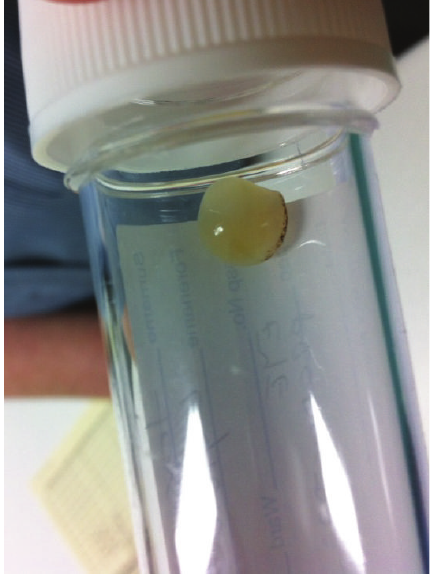
Figure 3: Extruded crystalline lens at the time of melting of the corneal